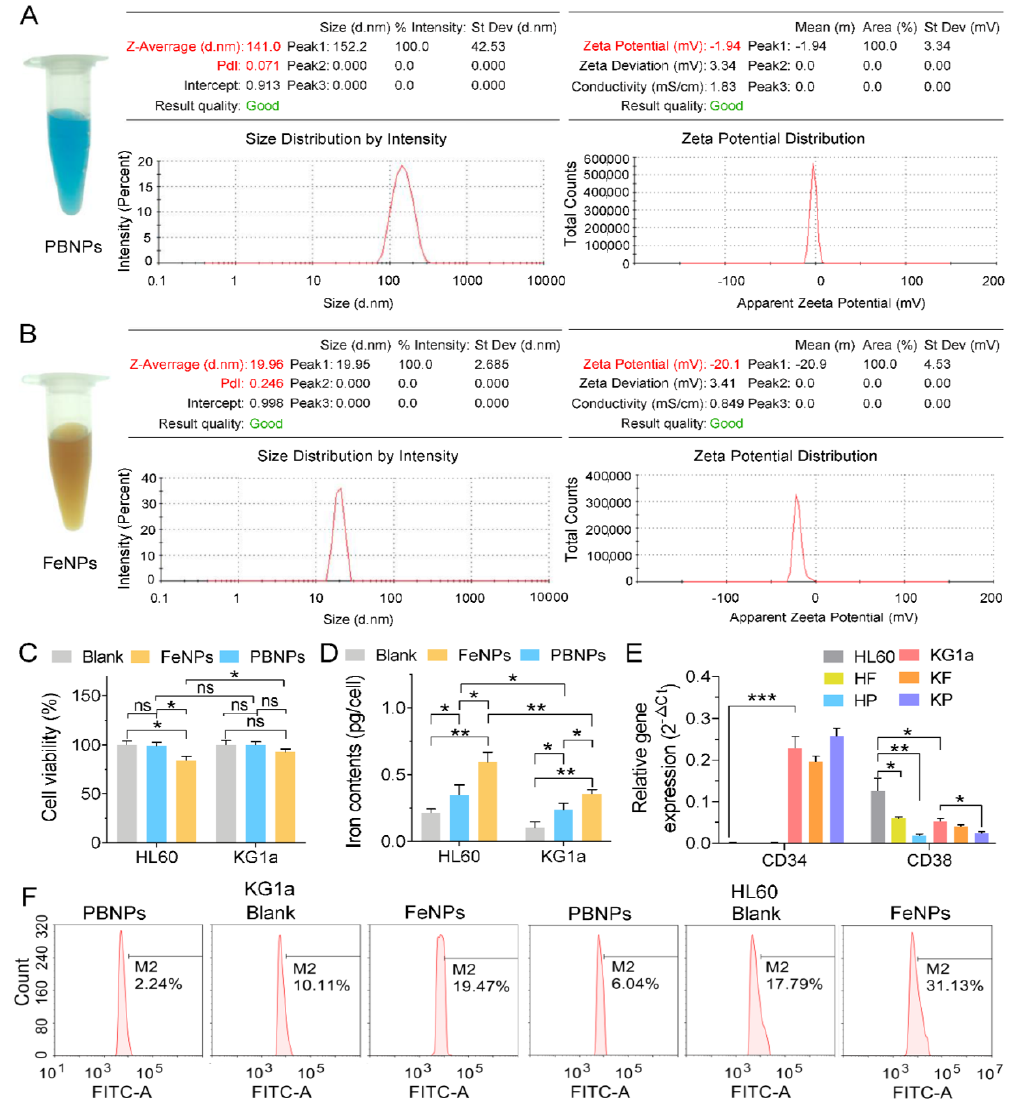
Figure 1. The characterization of two kinds of iron nanoparticles and their effects on KG1a and HL60: ( A , B ) hydrated particle size and zeta potential of Prussian blue nanoparticles (PBNPs) ( A ) and Fe 3 O 4 nanoparticles (FeNPs) ( B ), ( C ) cell viability of the PBNP- and FeNP-treated HL60 and KG1a cells, ( D ) cellular iron contents of the PBNP- and FeNP-treated HL60 and KG1a cells, and ( E ) QPCR detection of CD34 and CD38 expression in two cells. HF, FeNP-treated HL60; HP, PBNP-treated HL60; KF, FeNP-treated KG1a; KP, PBNP-treated KG1a. ns, no significance; *, p < 0.05; **, p < 0.01; ***, p < 0.001. ( F ) ROS levels of the PBNP- and FeNP-treated HL60 and KG1a cells.